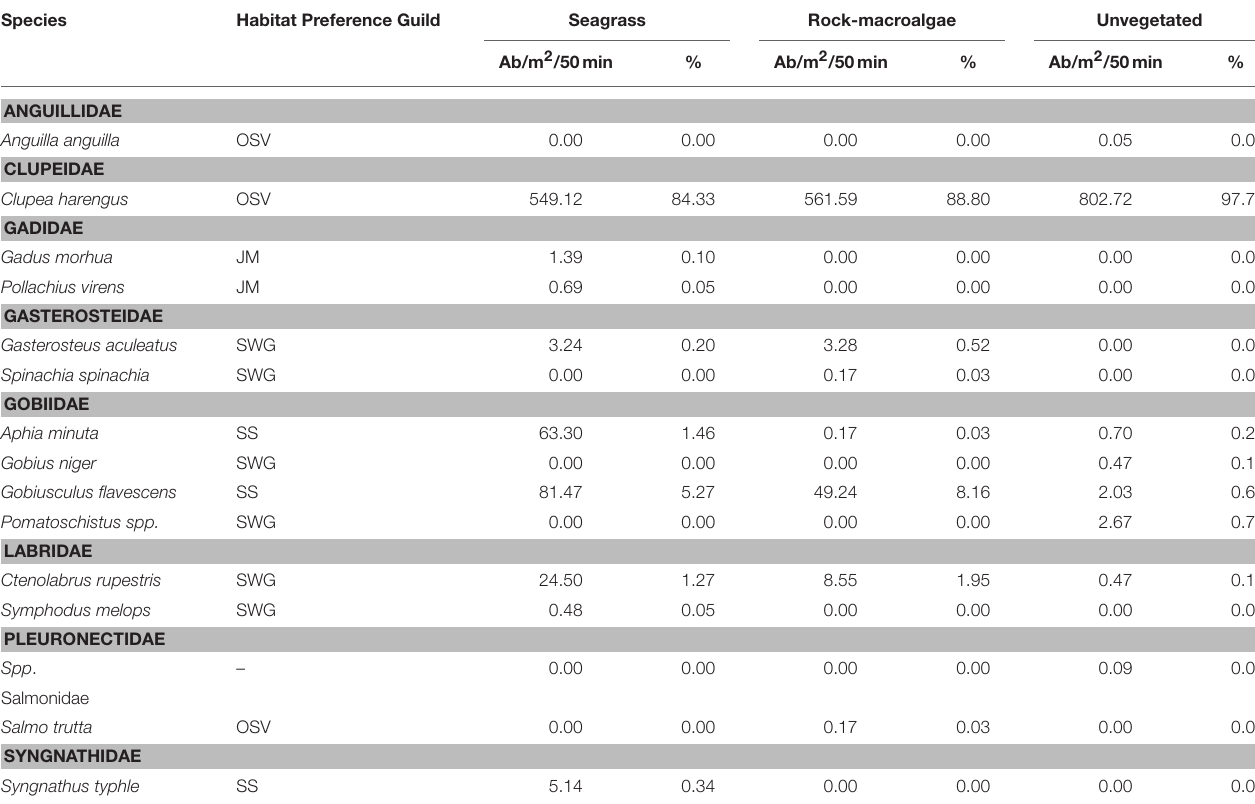
TABLE 1 | List of fish taxa identified from camera surveys in each of the three studied habitats (seagrass meadows, rocky bottoms covered by macroalgae and unvegetated soft bottom areas), their habitat preference guilds and the mean activity per m 2 (proxy for density) per 50min sampling period for each fish taxon as well as the percent of each species compared to the total abundance of fish within each habitat.